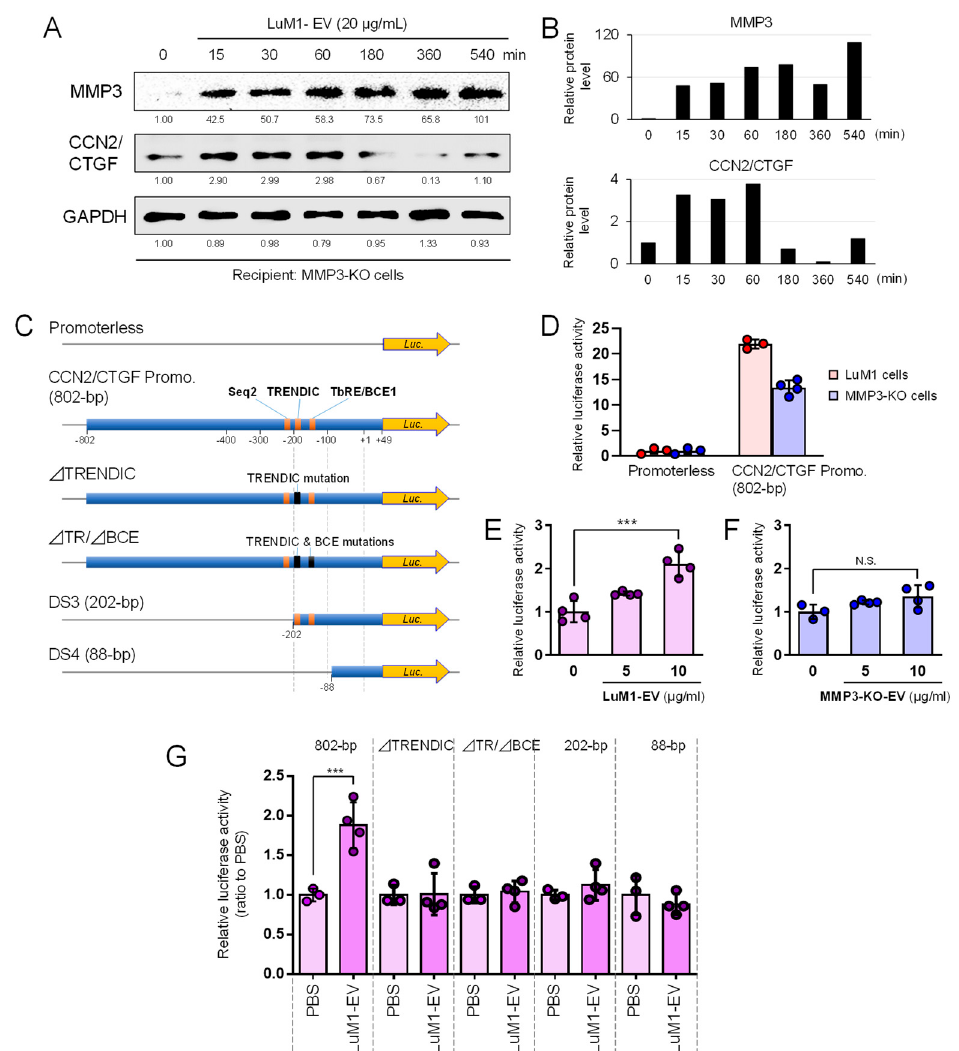
Figure 7. Oncosomal delivery of MMP3 induces CCN2 / CTGF through transcriptional activation. ( A , B ) LuM1-derived MMP3-rich EVs were added to culture media of the MMP3-null recipient cells at a final concentration of 20 µ g / mL. Cells were lysed at each time point (0, 15, 30, 60, 180, 540 min) after the addition of EVs. ( A ) Western blotting showing MMP3 and CCN2 in the recipient MMP3-KO cells. ( B ) The band intensities of MMP3 and CCN2, measured from panel A. The values relative to GAPDH are shown. ( C – G ) CCN2 / CTGF promoter response to LuM1- or MMP3-KO-EVs. ( C ) Schemes of reporter constructs. Top to bottom; a promoterless construct, human 802-bp CCN2 / CTGF promoter-driven luciferase (Luc.) reporter construct, ⊿ TRENDIC mutant, ⊿ TRENDIC / ⊿ BCE double mutant, and the 202-bp and 88-bp short promoter constructs (DS3 and DS4), respectively. ( D ) Relative activities of CCN2 / CTGF promoter in LuM1 vs. MMP3-KO cells. phRL-TK was used as a control reporter vector. *** p < 0.001, n = 3 to 4. ( E , F ) E ff ects of LuM1- and MMP3-KO-EVs on CCN2 / CTGF promoter activity in MMP3-KO cells. ( E ) LuM1-EVs or ( F ) MMP3-KO-EVs at final concentrations of 5 or 10 µ g / mL or PBS was added to the serum-free culture media of MMP3-KO cells. *** p < 0.0001, n = 3 to 4. N.S., not significant. ( G ) Oncosomal responsivities of 802-bp CCN2 / CTGF promoter and mutants. LuM1-EVs (10 µ g / mL) or PBS was added to the serum-free culture media of MMP3-KO cells. *** p < 0.0001, n = 3 to 4. The experiments were repeated twice in Figure